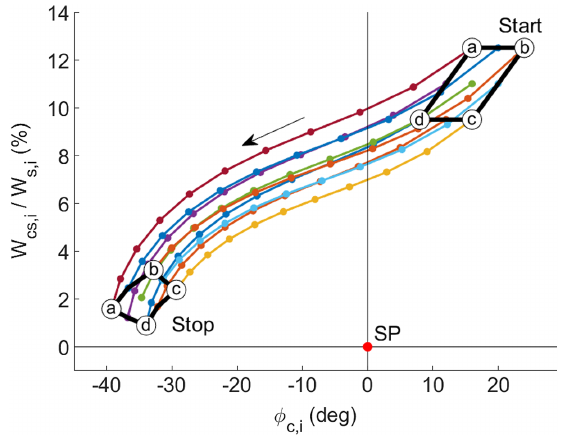
FIG. 8. Transformation of a well-oriented area abcd along the ten-gap acceleration section. Note that the energy deviation of the bunch centers is shown in percent of the steadily increasing SP energy along the section.